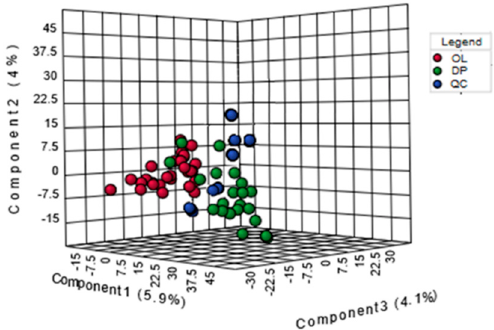
Figure 1. PLS-DA 3D plot based on normalized and mean-centered data. Each data point represents the metabolome of a single individual. In red are expressed sample collected in OL. In green are expressed samples collected in IL-DP. In blue are expressed QC.